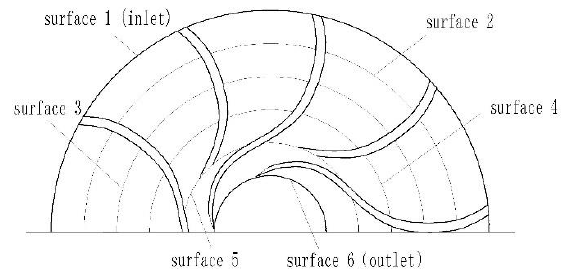
Figure 13. Monitoring surfaces of the impeller.